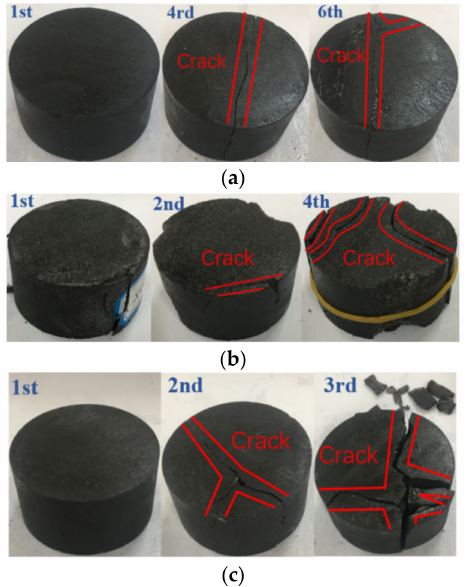
Figure 11. Failure morphology of the mudstone samples subjected to cyclic-impact loads: ( a ) 0.15 MPa; ( b ) 0.175 MPa; ( c ) 0.20